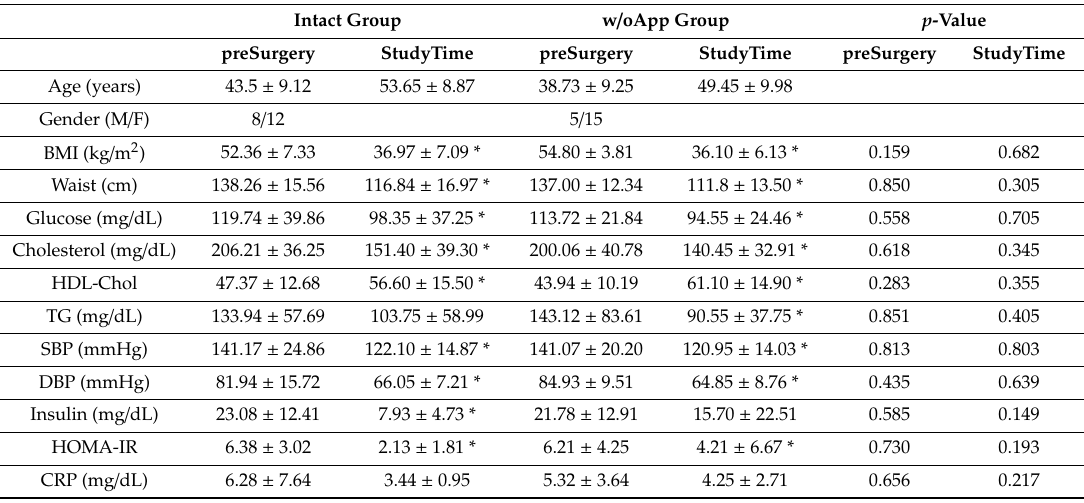
Table 1. Anthropometric and biochemical measurements before bariatric surgery and at the study